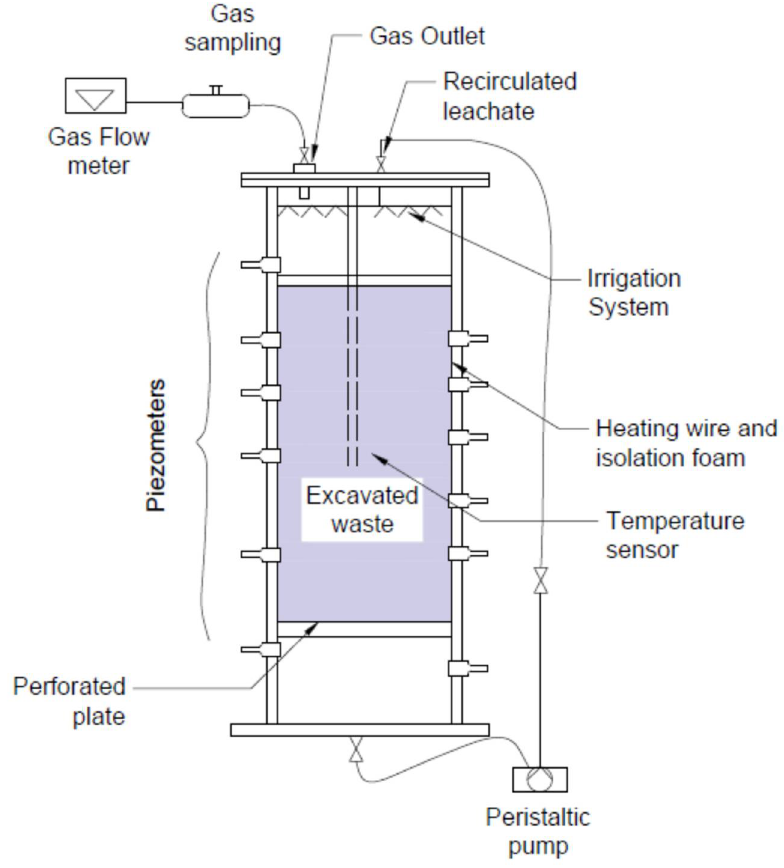
Figure 1. Landfill simulation reactor.